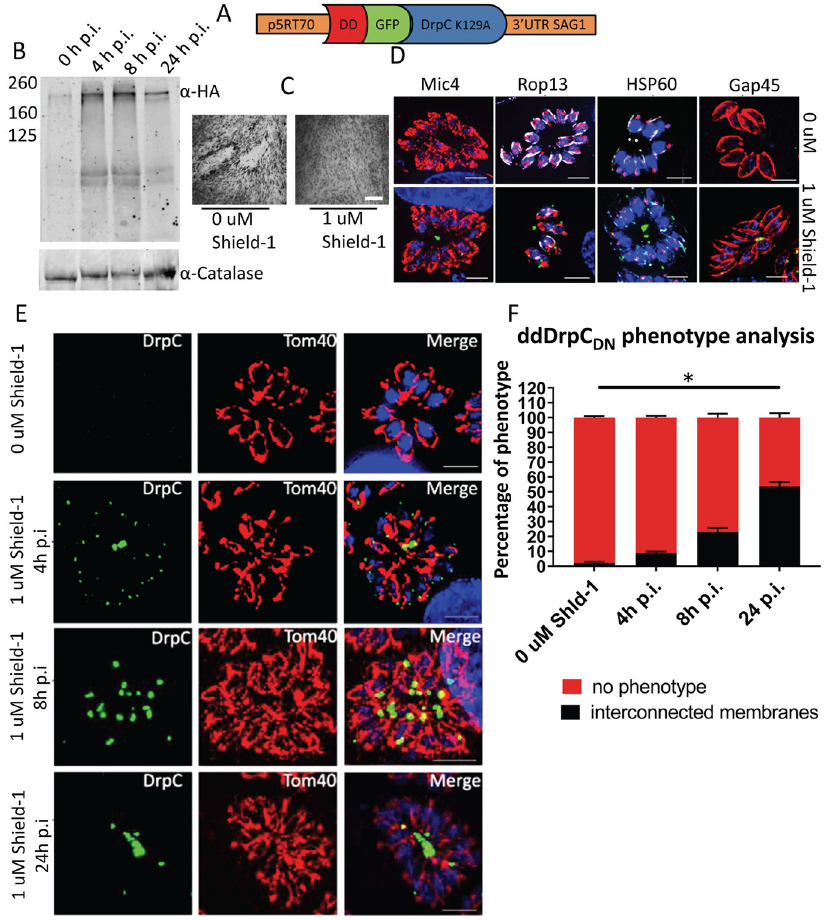
Fig 6. Over-expression of a dominant-negative form of Tg DrpC leads to interconnected mitochondria. A) Scheme of the plasmid DD-GFP-DrpCDN. (B) Western blot analysis with the indicated antibodies shows that Shield-1 induction efficiently regulates the expression of DD-GFP-DrpCDN as soon as 4 hours post induction. (C) Plaque assay shows that induction of DD-GFP-DrpCDN causes parasite death. Parasites were grown for 7 days on HFF cells in presence and absence of 1 μ M Shield-1. The experiment was performed in triplicate; representative images are shown. (D) The effects of DD-GFP-DrpCDN expression were assessed 24 hours after Shield-1 induction; immunofluorescence analysis of the specific markers Mic4, Rop13, HSP60 and Gap45 shows no effect on secretory organelles, apicoplast or IMC morphology. (E and F) Eight hours after stabilisation, DD-GFP-DrpCDN shows an accumulation at the basal part of the mitochondria, which increasingly appear interconnected (23% of the total); 24 hours after induction, more than half of the parasites show abnormally interconnected mitochondria, and DD-GFP-DrpCDN accumulates at the interconnections (scale bar: 5 μ m). At least 100 parasitophorous vacuoles were counted in triplicate. Error bars represent SD from the three independent experiments. Asterisks indicate significant difference (P < 0.001 multiple t-